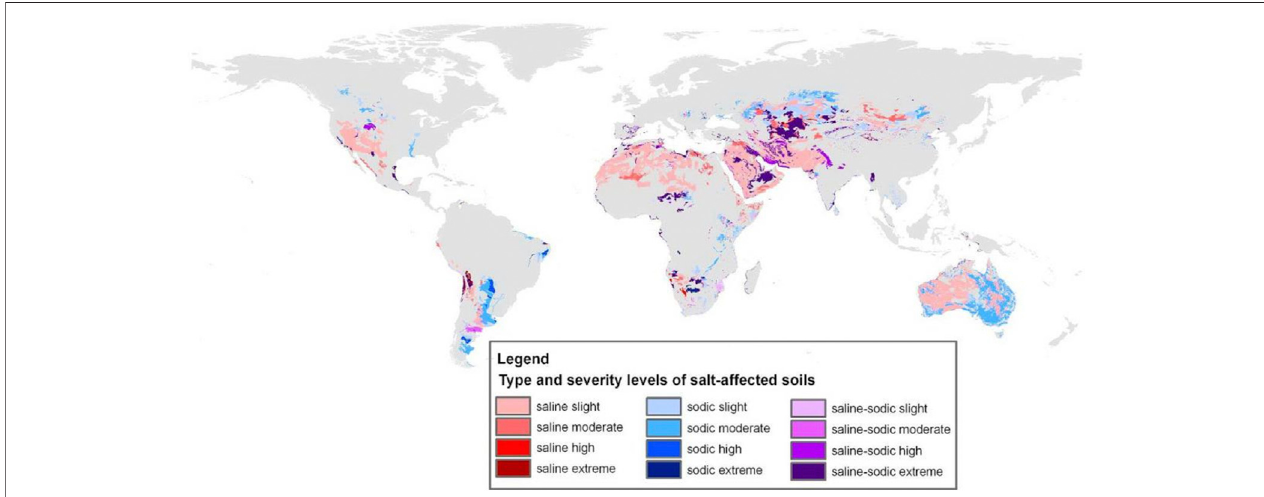
FIGURE 1 | Global distribution of saline, sodic, and saline-sodic soils. Source: Encyclopedia of the environment. https://www.encyclopedie-environnement.org/ en/zoom/land-salinization/.